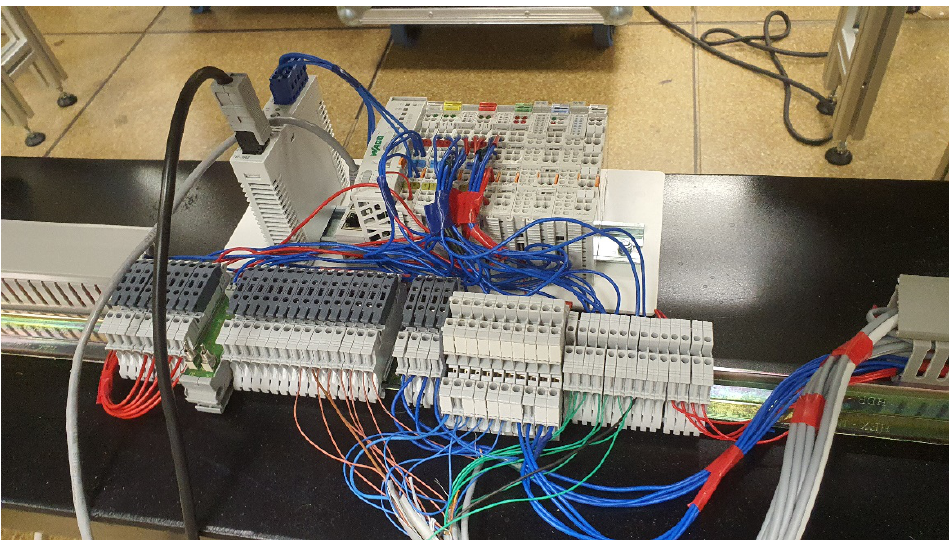
Figure 8. WAGO programmable field controller (PFC) 750-8100 . Figure 7. WAGO programmable field controller (PFC) 750-8100. Processes 2020 , 8 , x FOR PEER REVIEW 12 of 17